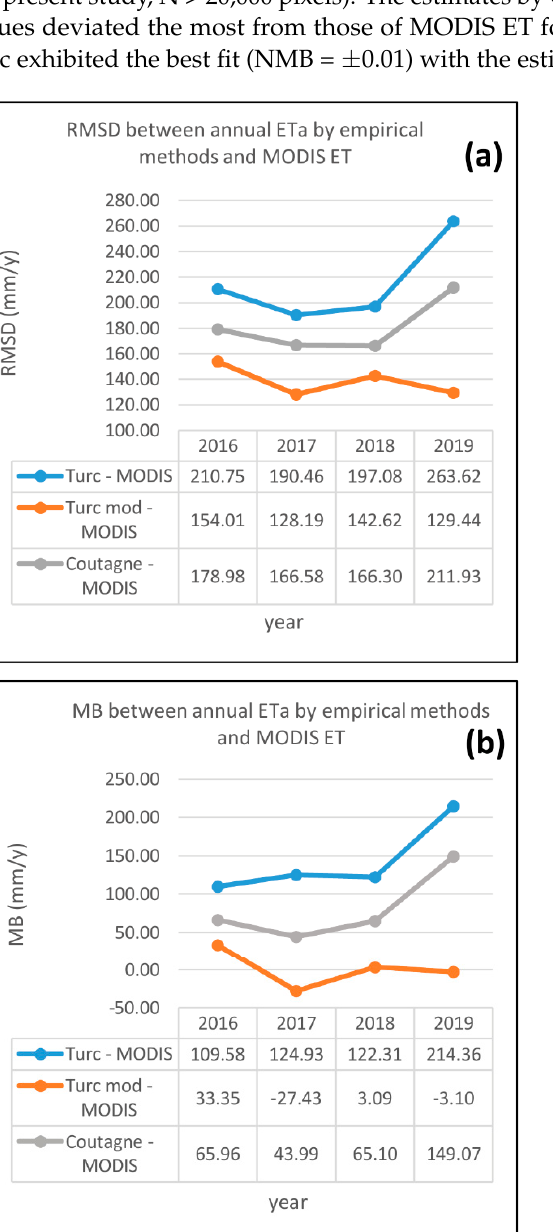
Figure 5 . Comparison between ( a ) RMSD, ( b ) MB, and ( c ) NMB of ETa by empirical methods and MODIS ET for 2016 – 2019 .